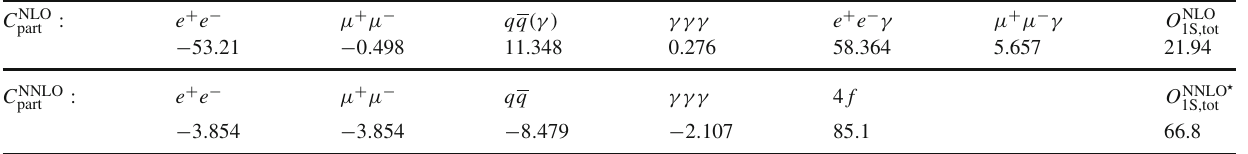
Table 5 Coefficients for the sum of all NLO and NNLO corrections of each partial ortho-ditauonium decay channel, C NLO,NNLO part , and final O NLO and O NNLO (cid:19) correction terms asdefined inEqs. (54) and (55) for 1S,tot 1S,tot